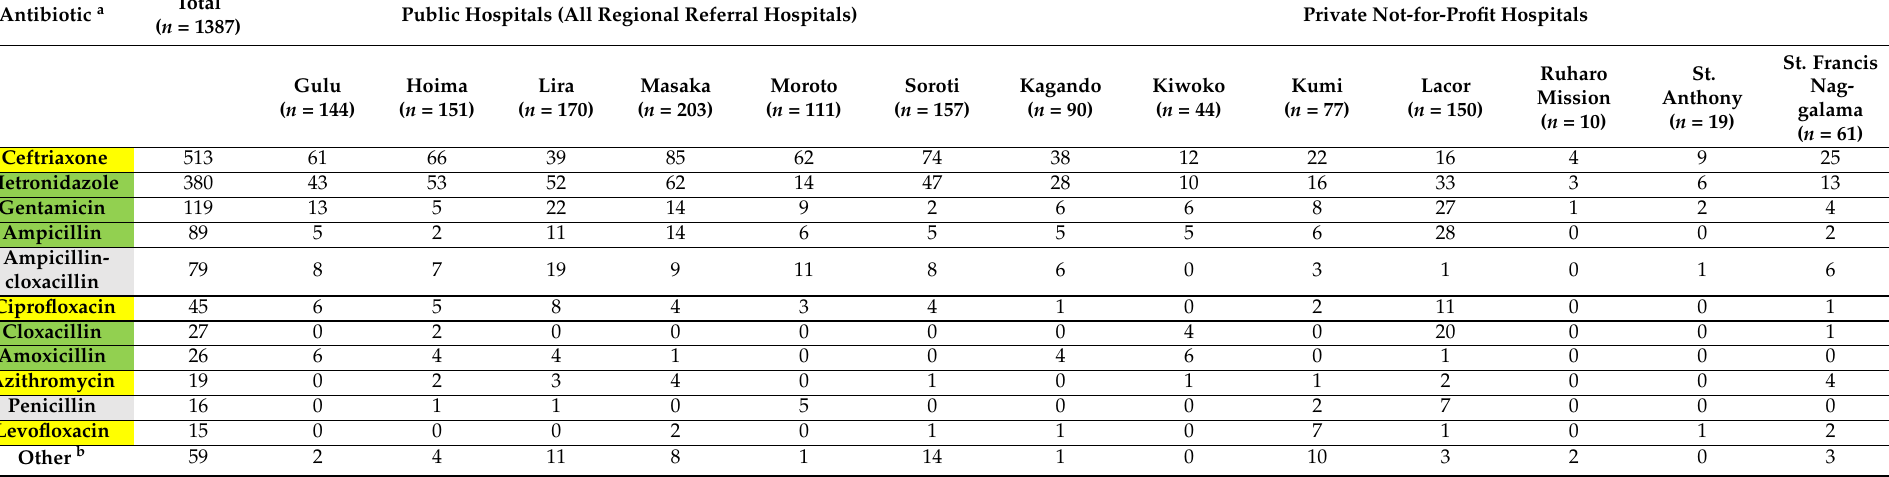
Table 3. Prevalence of specific antibiotic use by